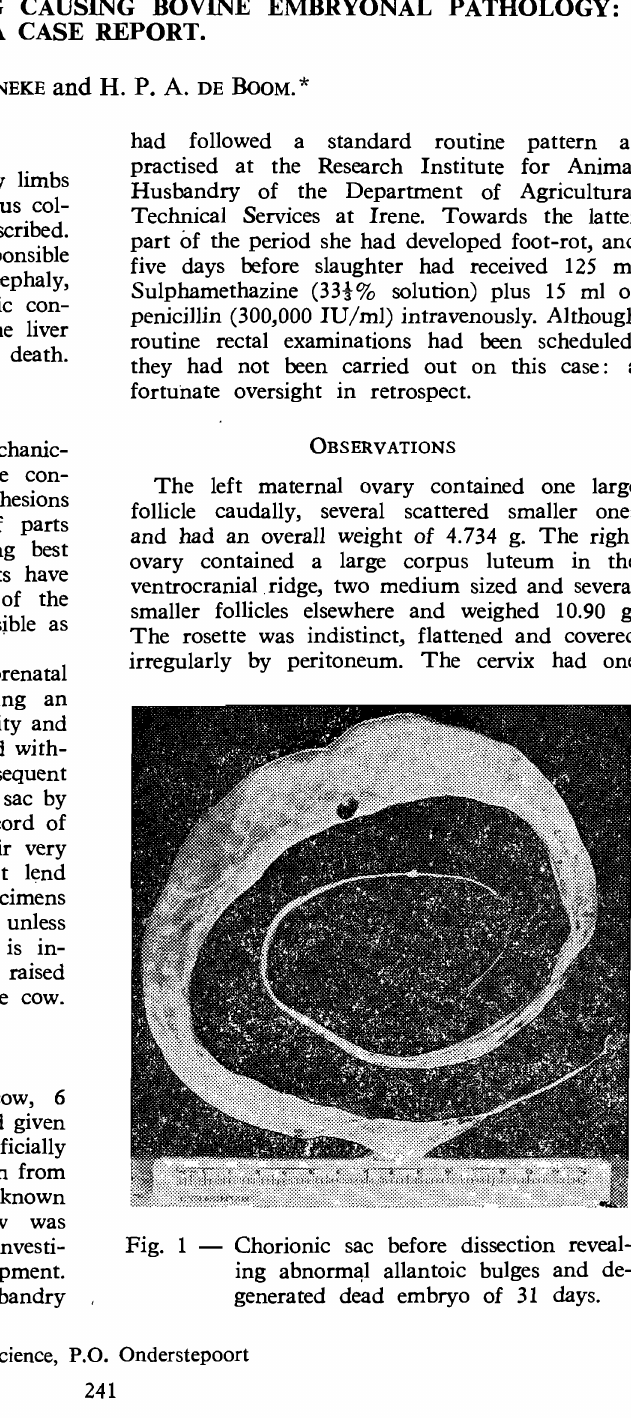
Fig. 1 - Chorionic sac before dissection reveal generated dead embryo of 31